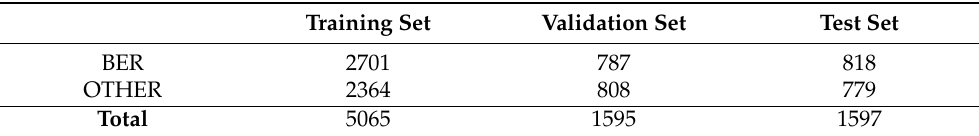
Table 6. Details of the dataset for training classification networks. "BER" refers to tomatoes with BER, while "OTHER" contains images such as healthy tomatoes, backgrounds, and so on that do not belong to "BER".